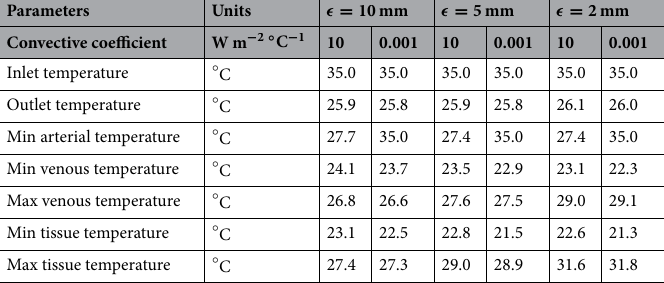
Table 4. Temperature for different simulation